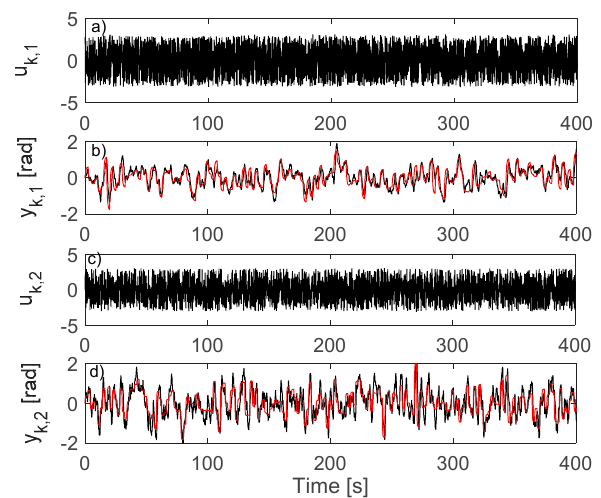
(red); ( c ) u k ,2 ; ( d ) y k ,2 (black), y m k ,1